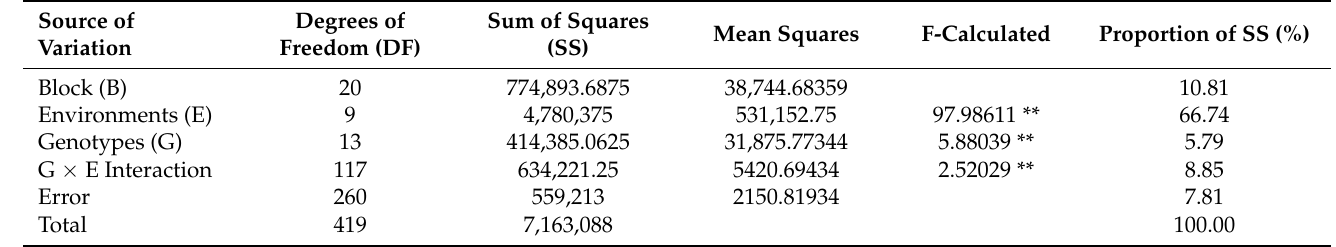
Table 4. Mean squares for hybrid grain yield under genotype by environment interaction study in 2021.